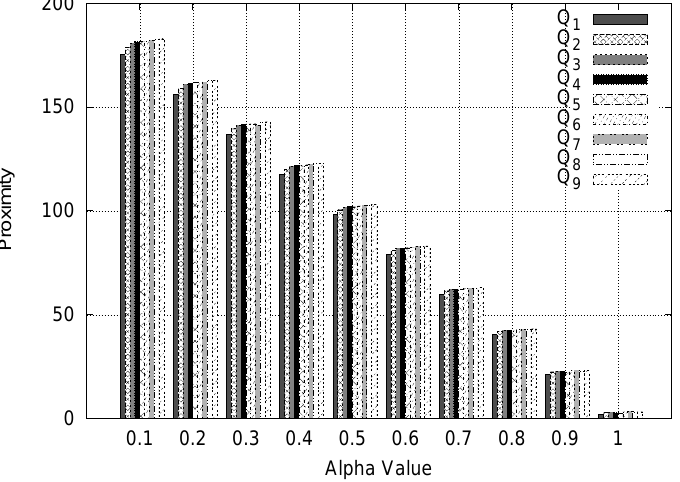
Figure 17. Varying value of alpha.